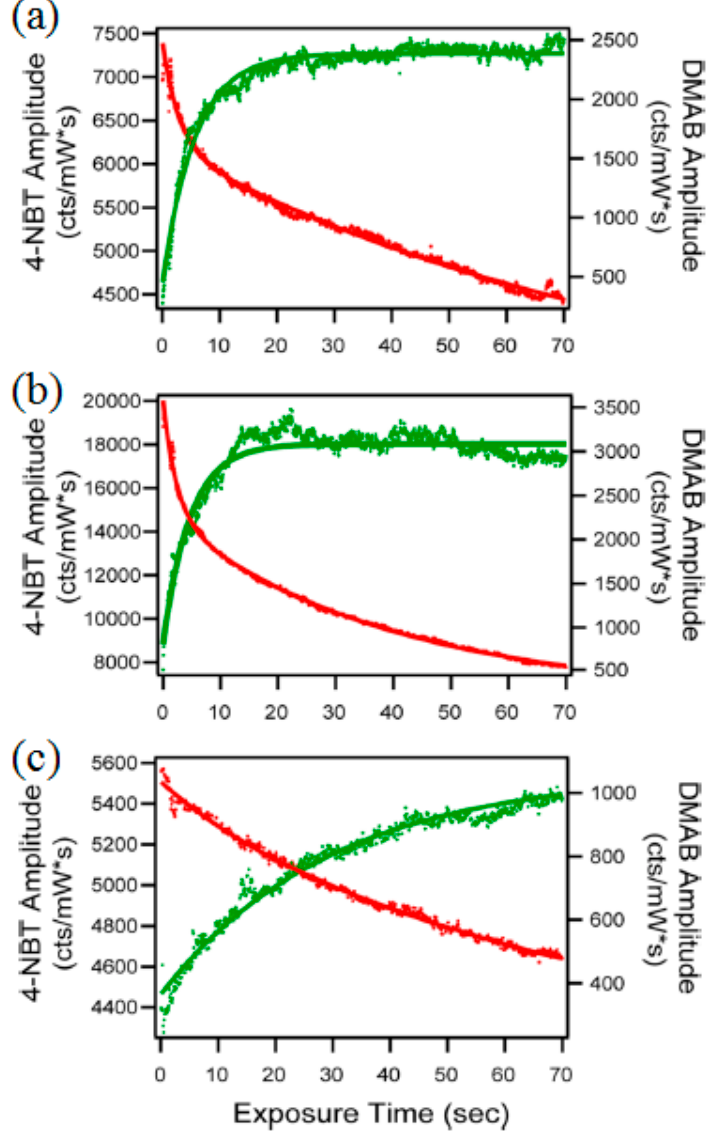
Figure 10. Reaction kinetics of 4NBT to DMAB plasmon-induced photoreactions. ( a ) The 4NBT reactant amplitude rapidly decreases with concurrent growth of product amplitude. At longer times, reactant peak experiences additional decay, while product amplitude remains constant; ( b ) similar to (a), but with a slight decrease in product amplitude at longer times; ( c ) in a weakly enhancing environment, reactions occur more slowly [45].